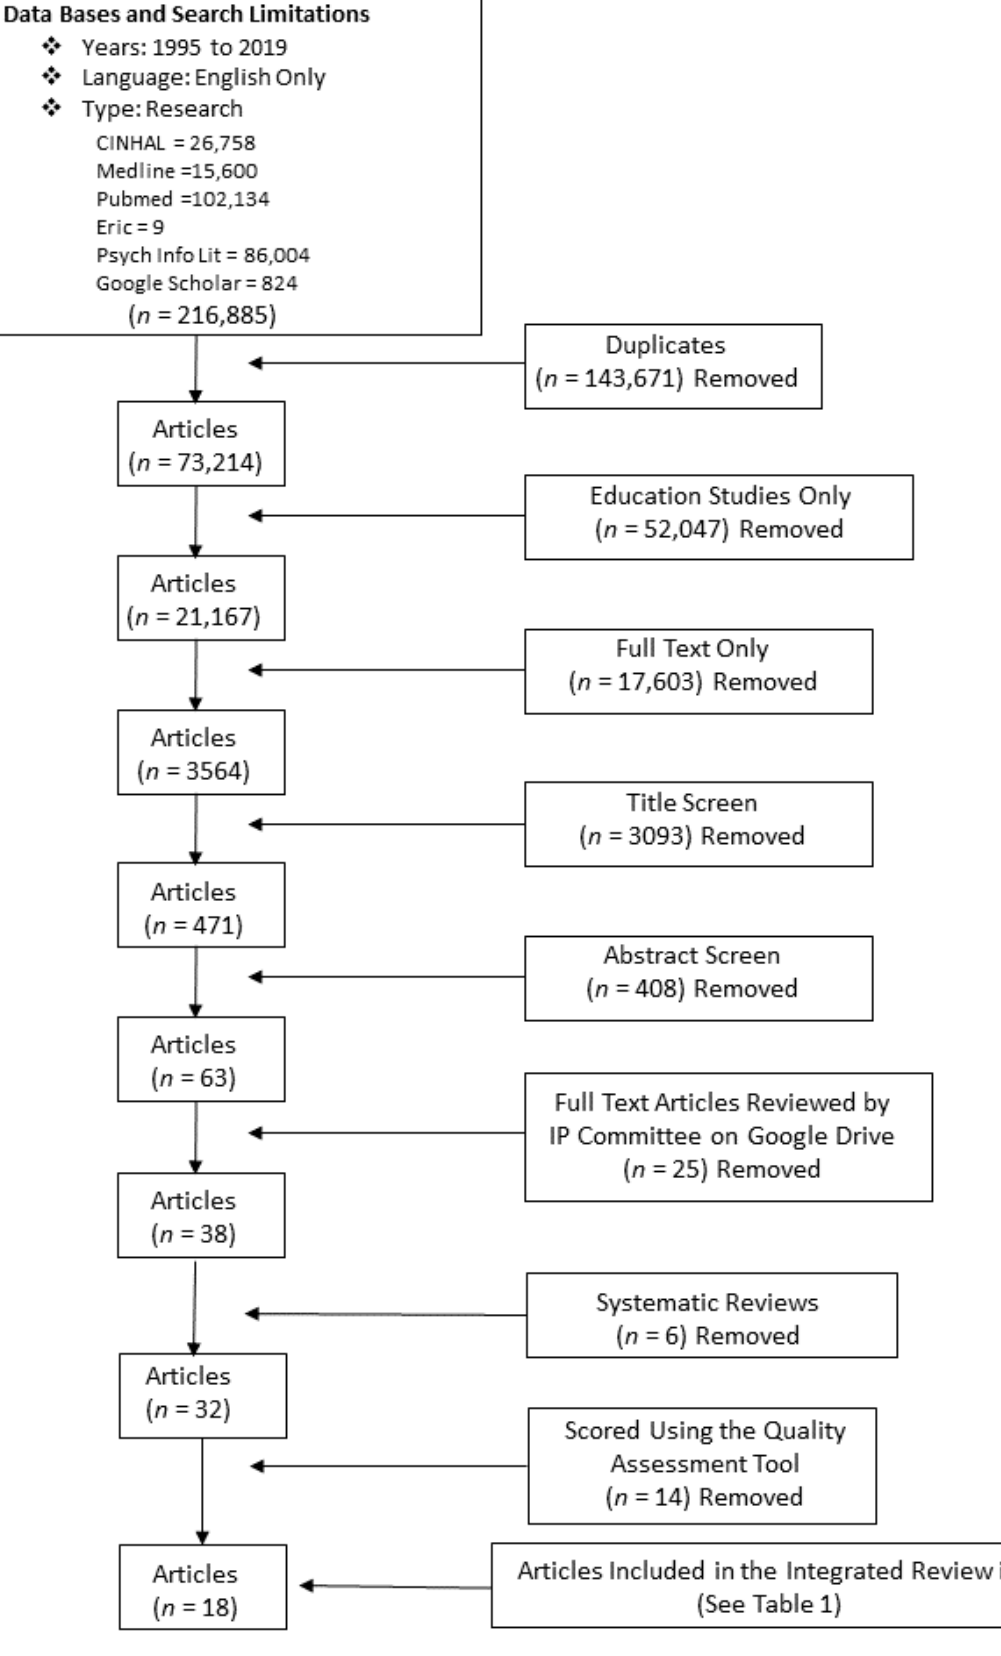
Figure 1. Search Figure 1. Search Strategy.